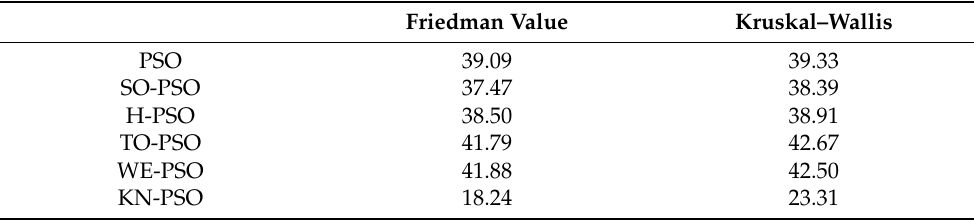
Table 5. Mean ranks obtained by Kruskal–Wallis and Friedman test for all PSO-based